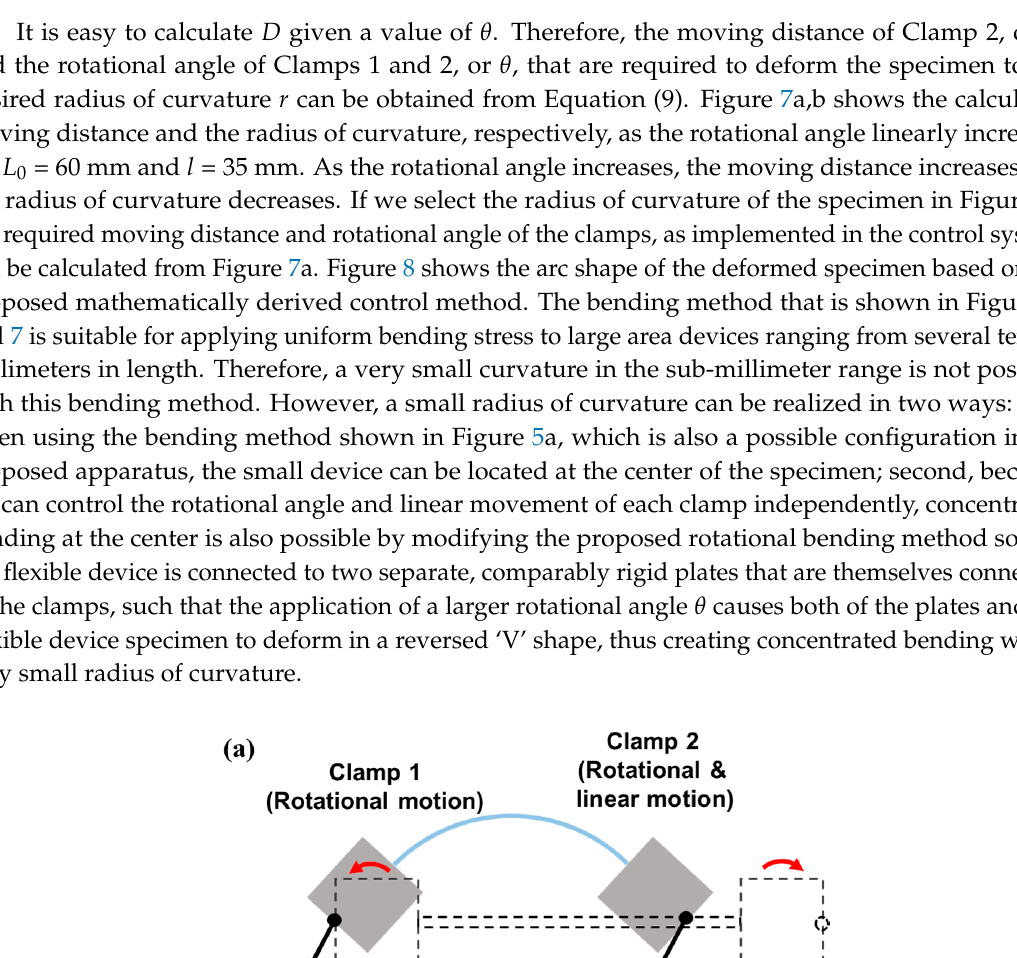
Figure 7. Calculation results of parameters to obtain the desired radius of curvature of the bent specimen: ( a ) relationship between the rotational angle and moving distance of Clamp 2; ( b ) relationship between the rotational angle and radius of curvature.